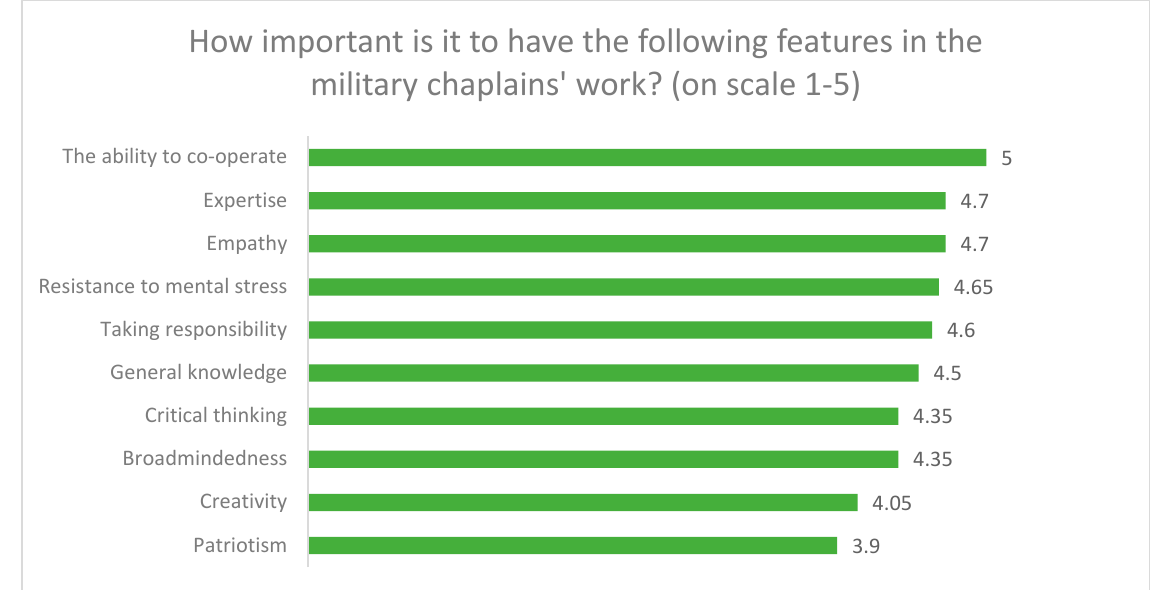
Figure 3. How important is it to have the following features in a military chaplain’s work?